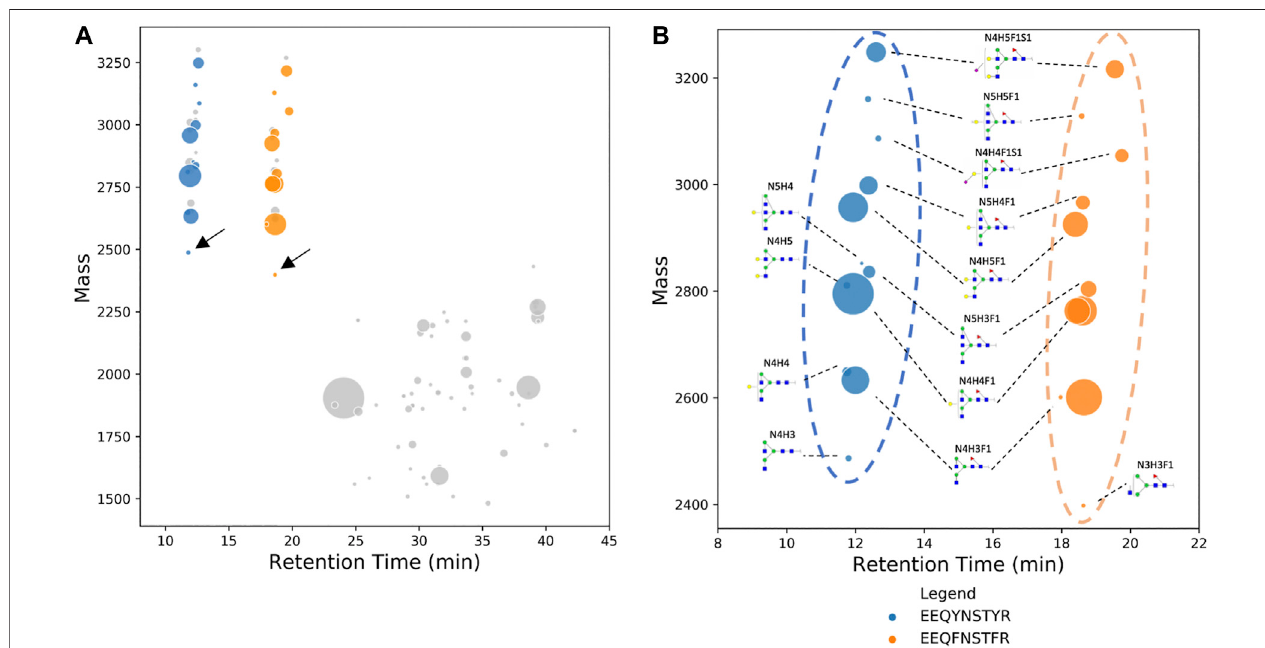
FIGURE2|(A) DeconvolutedmassofhumanserumIgGglycopeptidesareplottedonabubblechartagainsttheirrespectiveretentiontime.Nodeswiththelowest neutral mass in each subgraph, also known as reference nodes, are compared against the database of IgG glycopeptide masses. Two reference nodes (labeled with arrows), among other non-glycopeptide nodes (in gray), matched IgG glycopeptide mass and their composition was manually assigned. (B) Bubble chart of the deconvolutedmassofglycoformsofEEQY N STYR(humanserumIgG1)andEEQY N STYR(humanserumIgG2)againsttheirrespectiveretentiontime.Identi fi cation of glycan composition was performed using GraphMS. The plot shows a clear distinction between IgG1 and IgG2. In some cases, glycopeptides are plotted separately as two nodes due to the slight difference in retention time (N4H3F1 and N4H4F1 of EEQY N